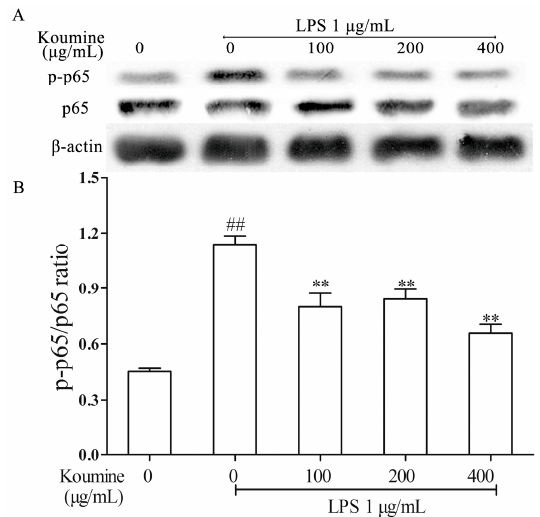
Figure 4. Effect of koumine on the expressions of p-p65 and p65 proteins in LPS stimulated RAW264.7 cells. Cells were pretreated with 100, 200 or 400 μ g/mL koumine for 6 h. Subsequently, cells were treated with 1 μ g/mL LPS in the mediums containing koumine for 1 h. Equal amounts of p65 and p-p65 proteins in cell lysates were analyzed by Western blot. ( A ) The expression levels of p-p65 and p65; and ( B ) The quantification histogram of p-p65 protein expression normalized by p65. The data were expressed as mean ± standard deviations (SD) ( n = 3). ## p < 0.01 vs. control group; ** p < 0.01 vs. LPS group.